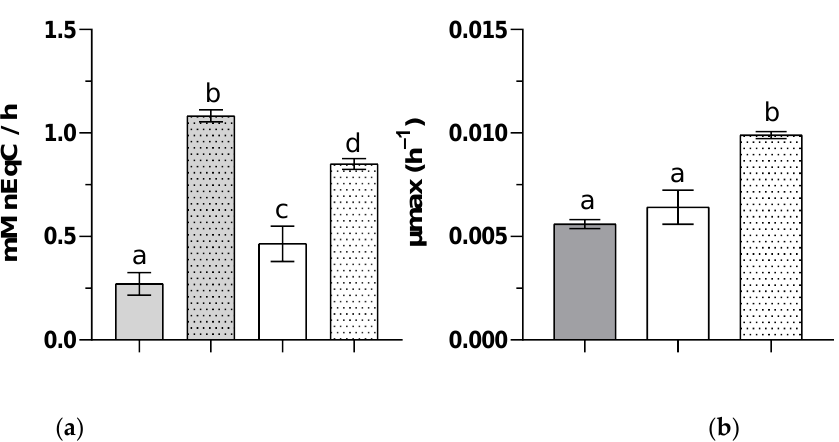
Figure 2. Carbon source consumption rate ( a ) and biomass growth rate ( b ) of Rs. rubrum grown using propionate ( ■ ), butyrate (□), or a mixture of these VFA S ( ) as the carbon source (n = 5).